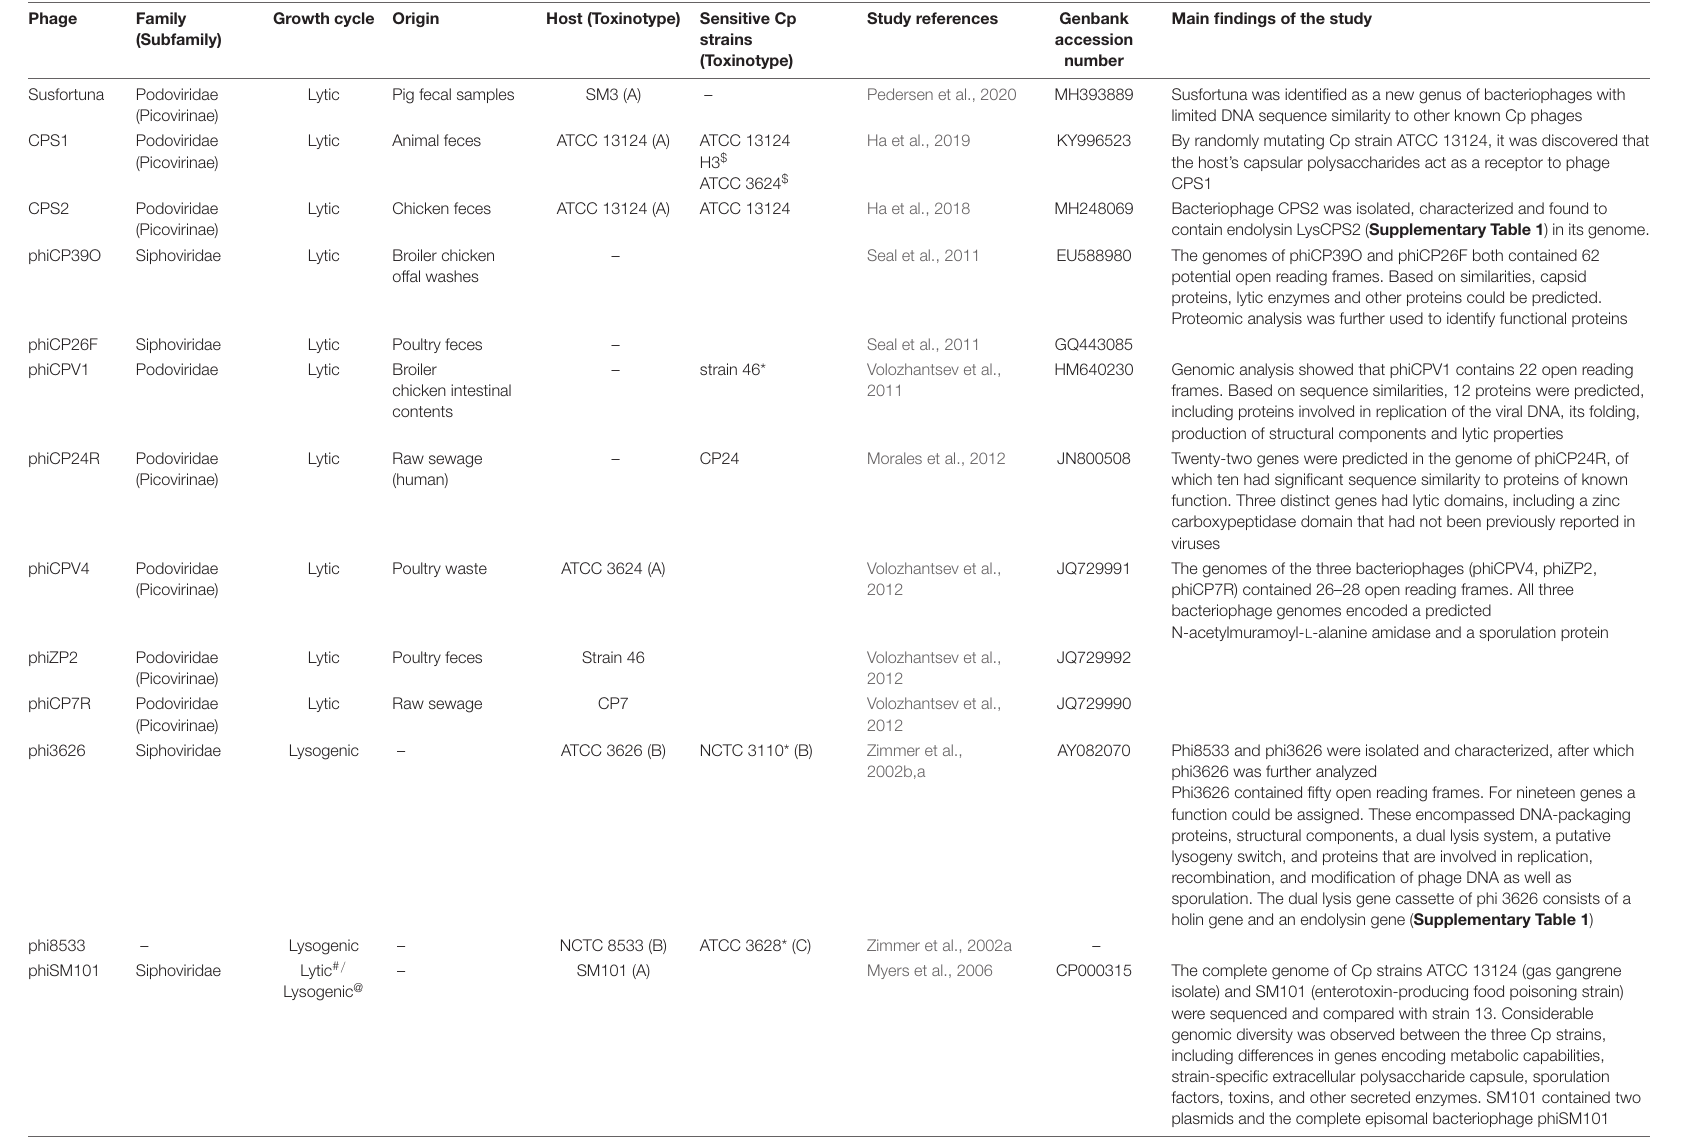
TABLE 1 | Clostridium perfringens phages characterized to date, as described in the referenced